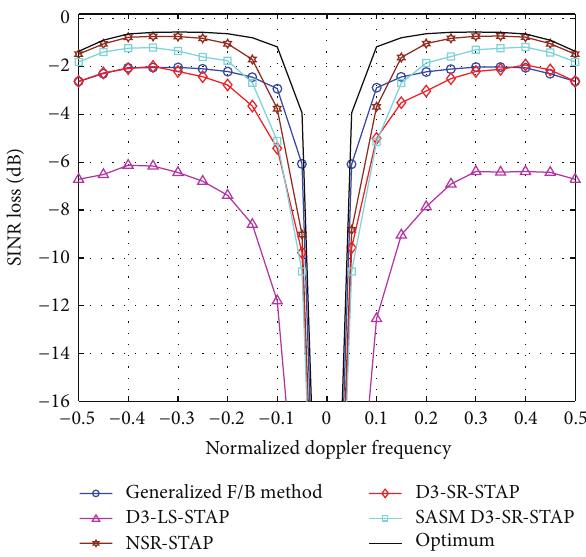
Figure 7: SINR loss against the target Doppler frequency consider- ing channel mismatch.